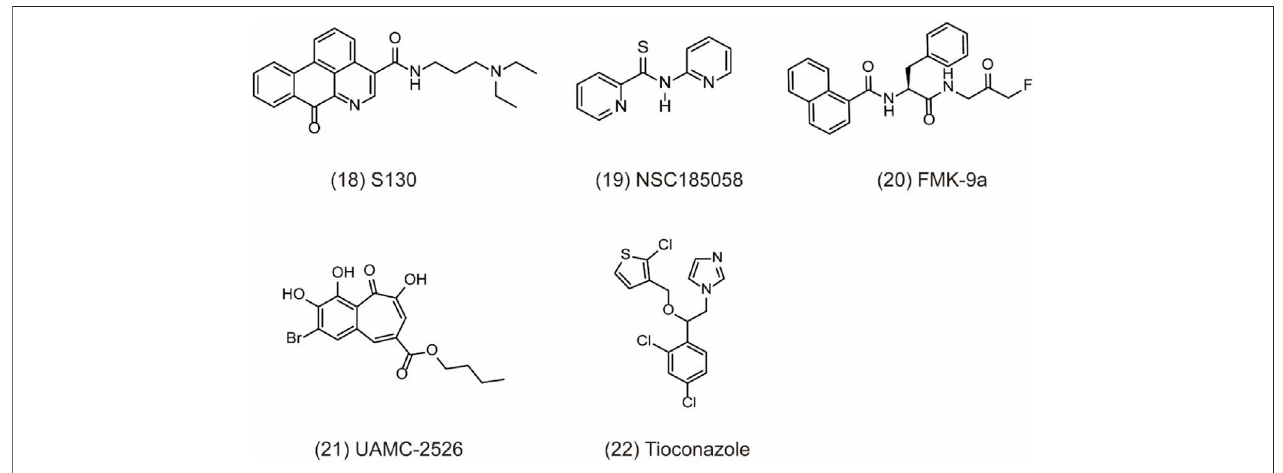
FIGURE 5 | Chemical structures of 18 – 22 as inhibitors of autophagy by targeting